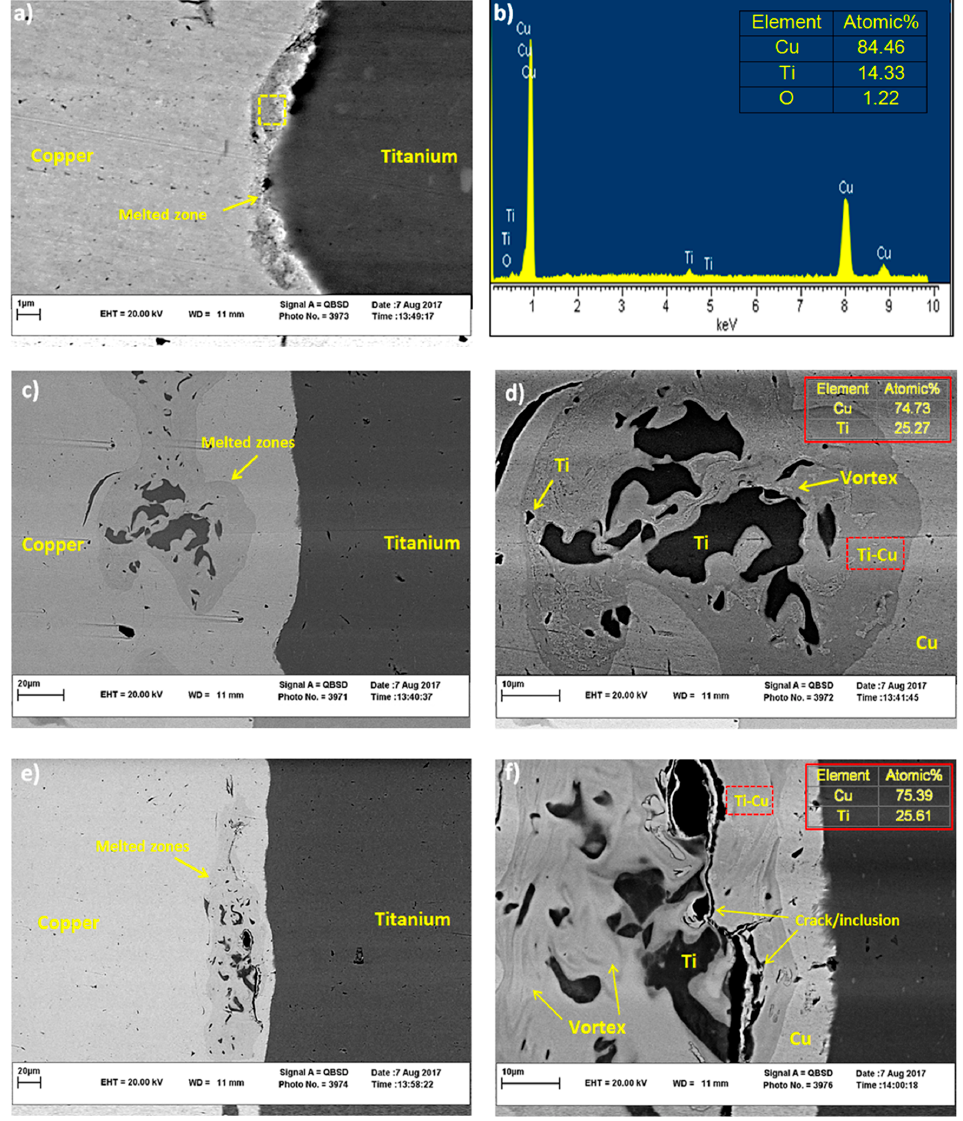
Figure 3. SEM images of ( a , b ) the welded interface with EDS analysis results, ( c , e ) LMZs, ( d , f ) greater magnification and EDS results of Ti-Cu phase at LMZs corresponding to ( c , e ) along with